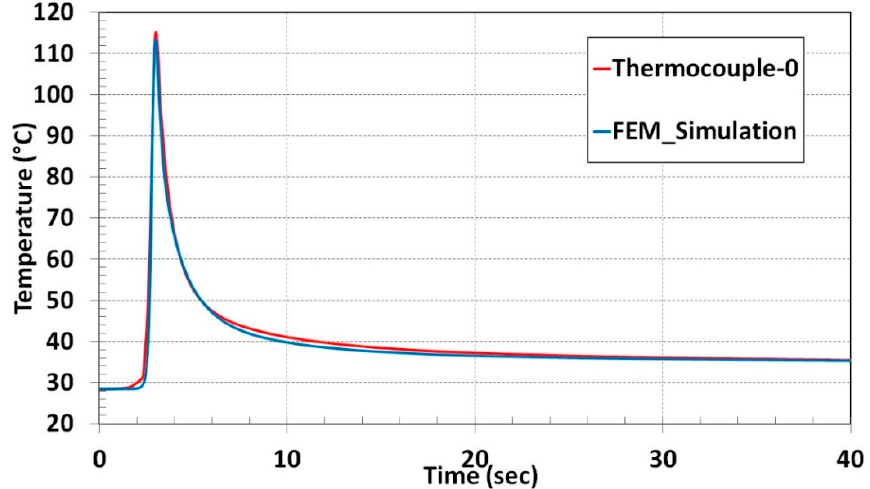
Figure 7. Numerical result and experiment temperature comparison for single-track deposition.